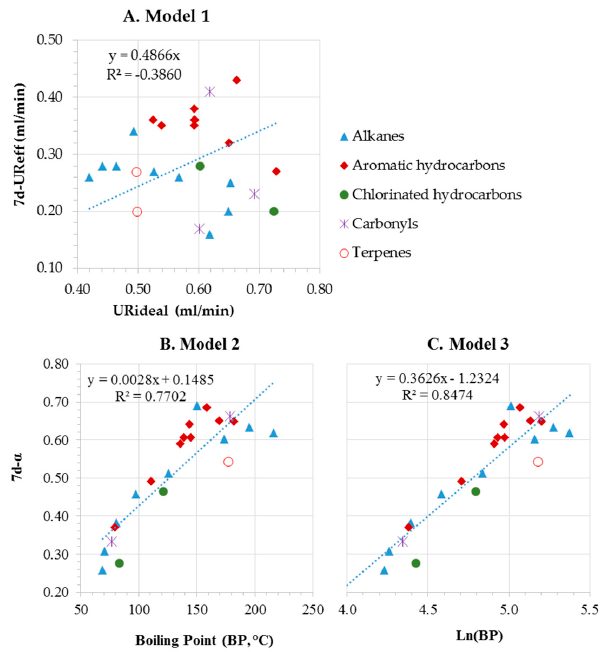
Figure 4. Comparison of three models for estimating 7d-UR eff or 7d- α values in environmental sampling.